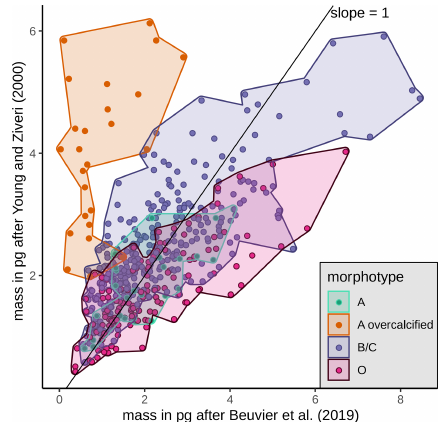
Figure A2. Comparison of mass estimates using two different for- mulas (Beuvier et al., 2019; Young and Ziveri, 2000). Black line indicates a slope of 1.